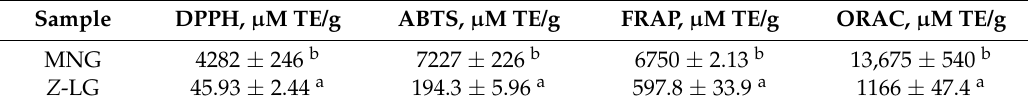
Table 1. Antioxidant capacity characteristics of MNG and Z